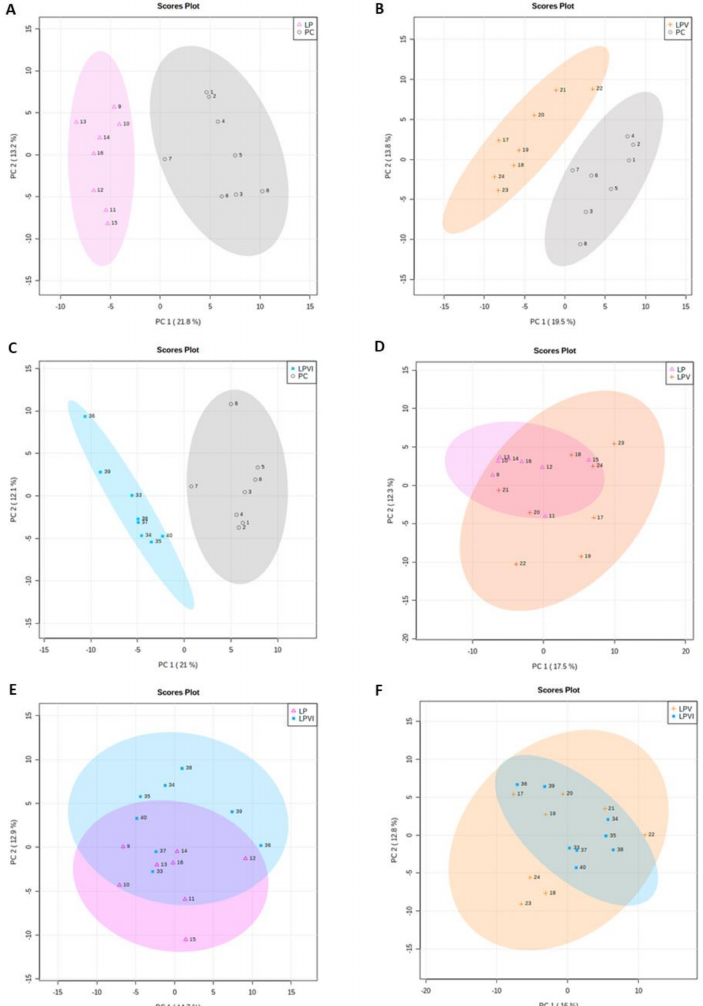
Figure 7. Principal component analysis (PCA) score plots of plasma metabolites in nursery pigs fed with very-low-protein diets supplemented with Ile, Val, or combination of both. ( A ) LP vs. PC, ( B ) LPV vs. PC, ( C ) LPVI vs. PC, ( D ) LPV vs. LP, ( E ) LPVI vs. LP, and ( F ) LPVI vs. LPV. PC (positive control): standard-protein diet; LP (negative control): low-protein diet containing limiting amino acids (i.e., Lys, Met, Thr and Trp) at NRC (2012) levels; LPV: LP containing Val at NRC level; LPI: LP containing Ile at NRC level; LPVI: LP containing Val and Ile at NRC levels. Each shape represents a pig. n =